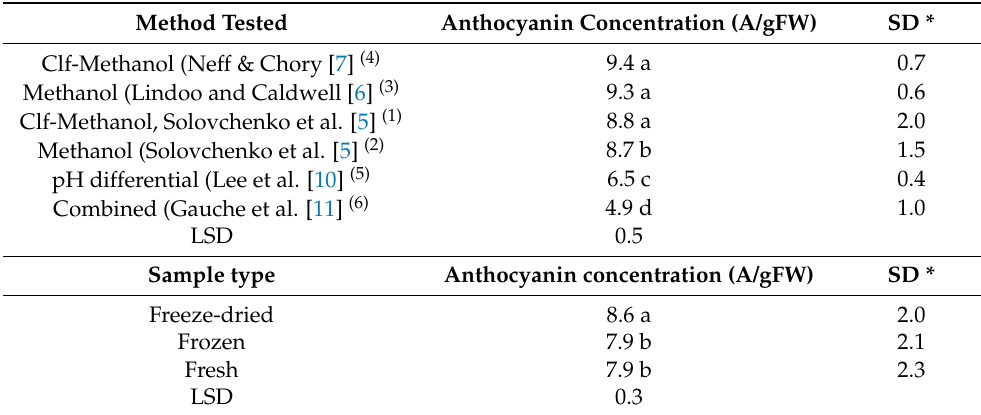
Table 1. Total anthocyanin content of fresh, frozen and freeze-dried strawberry puree measured by organic solvent and pH differential methods. Method